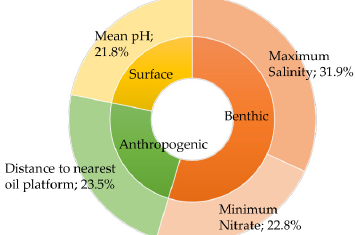
Figure 2. Relative contribution (%) of the four variables used in our final model.